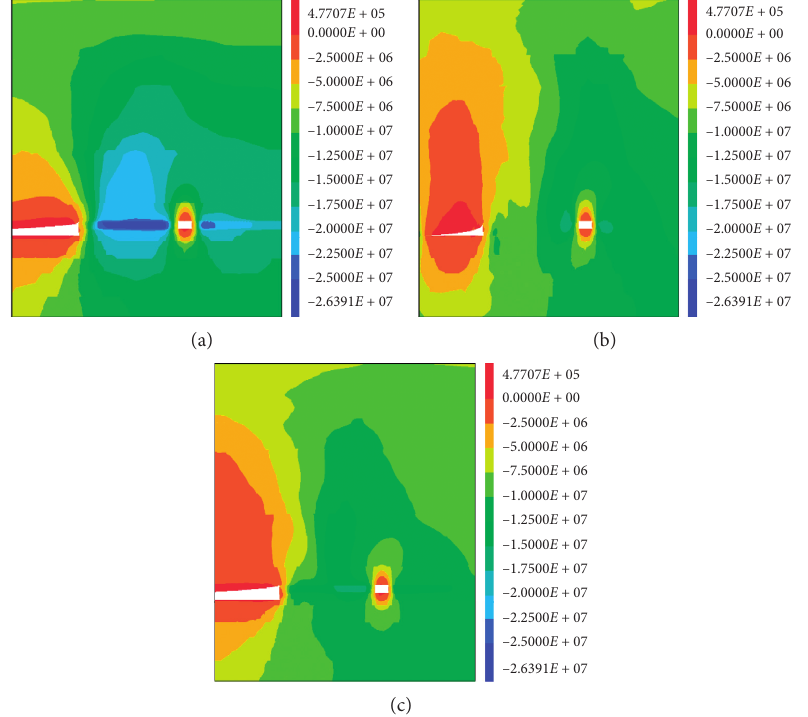
Figure 3: Vertical stress nephogram of cut